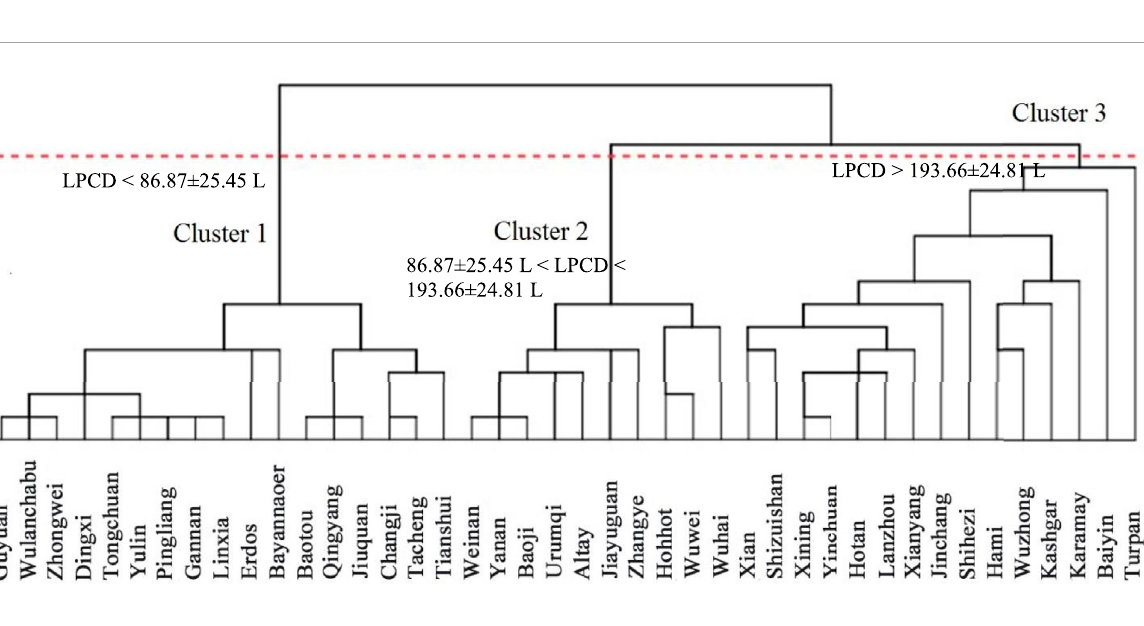
FIGURE 3 Clusters of liters per capita per day in 42 cities located in Northwest China. Note: The dashed red line corresponds to a classi fi cation